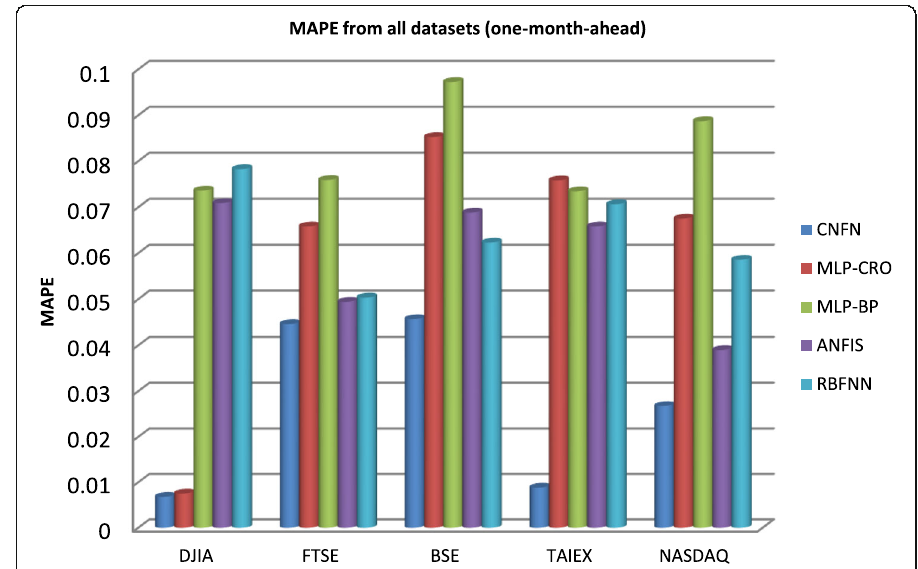
Fig. 12 MAPE generated by all models from all datasets (One-month-ahead)